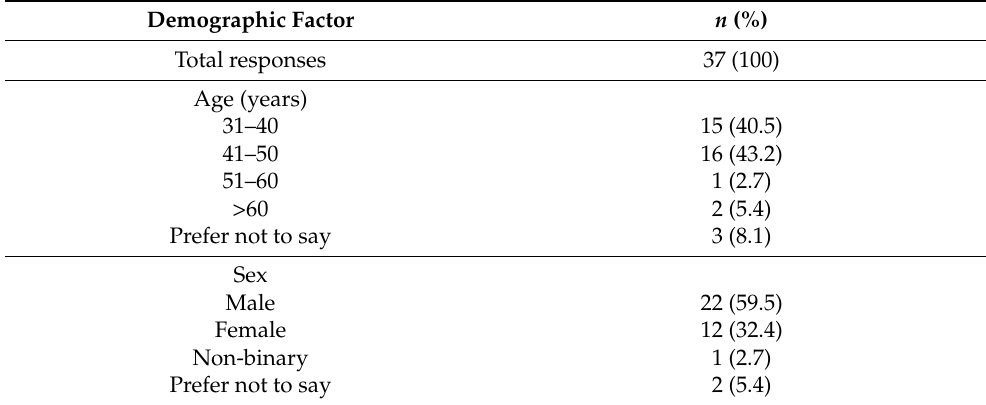
Table 1. Demographic characteristics of